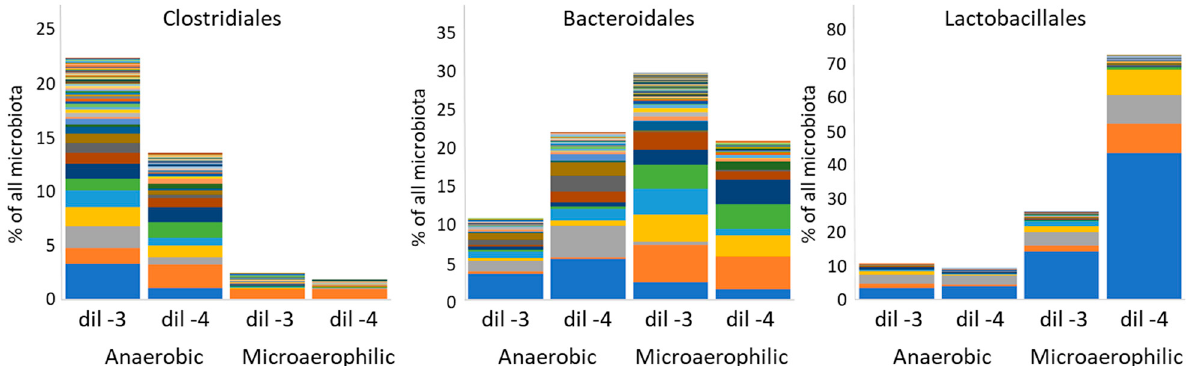
Figure 6. Recovery of the main gut microbiota members from Wilkins-Chalgren agar after culture under anaerobic or microaerophilic conditions. The caecal content of a donor hen was serially diluted and dilutions-3 and -4 were plated on WCHA agar plates, which were incubated under anaerobic or microaerophilic conditions. All growing colonies were washed, and the composition of microbial biomass was determined by sequencing of 16S rRNA genes. Y axis shows abundance of each order in washes from the plates with individual OTUs belonging to each order highlighted by different colours. Vegetative cells of Clostridiales grew only under strictly anaerobic conditions. Lactobacillales preferred microaerophilic conditions and Bacteroidales grew similarly both in anaerobic and microaerophilic conditions. For identification of each OTU contributing to anaerobic or microaerophilic growth of these 3 orders, please, see Table S5.